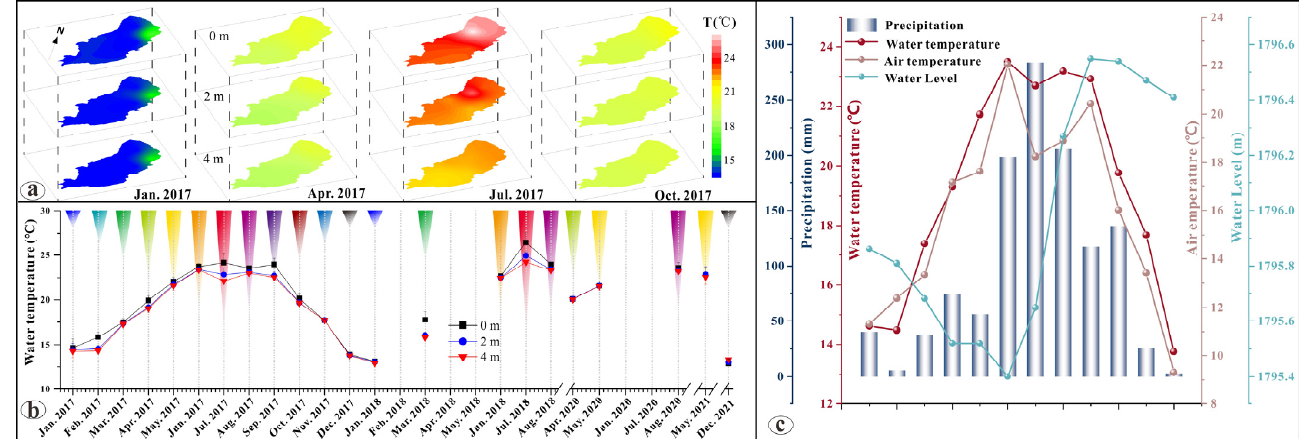
Figure 2. Seasonal and interannual variations in water temperature in lake QL. ( a ) Seasonal variations in water temperature; ( b ) Interannual variations in water temperature; ( c ) Monthly changes in precipitation, air temperature, water temperature, and water levels in Lake